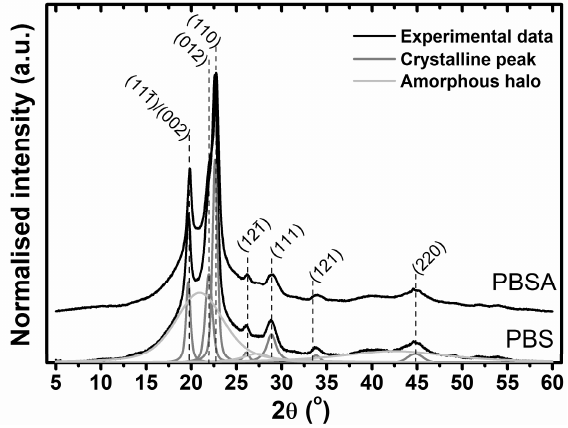
Figure 5. X-ray diffraction profiles of PBS and PBSA samples with deconvolution to the amorphous and crystalline compounds.